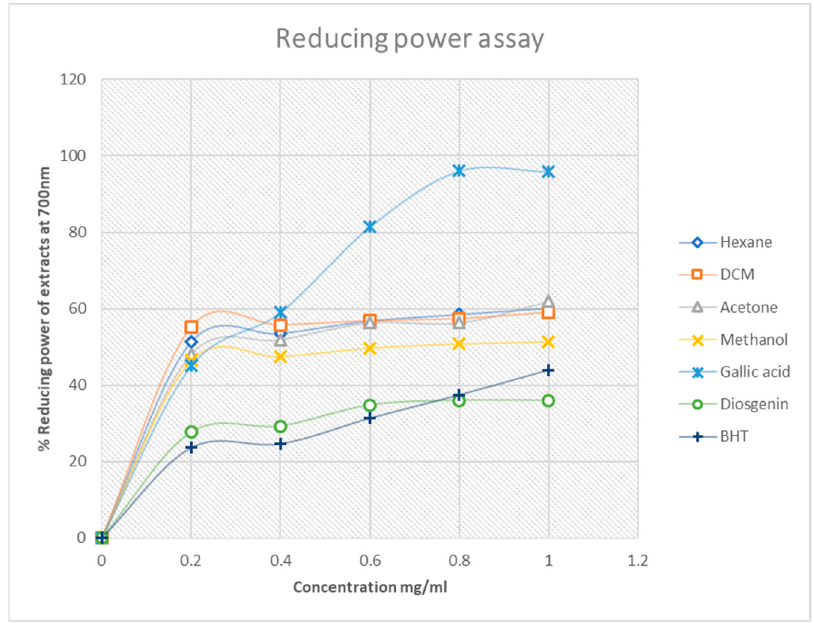
Figure 5. Percentage reducing power of Mistletoe extracts and standards. Each value is expressed as mean ± standard deviation ( n = 3). Table 4. IC 50 values indicating the potential inhibition by the four Mistletoe extracts.